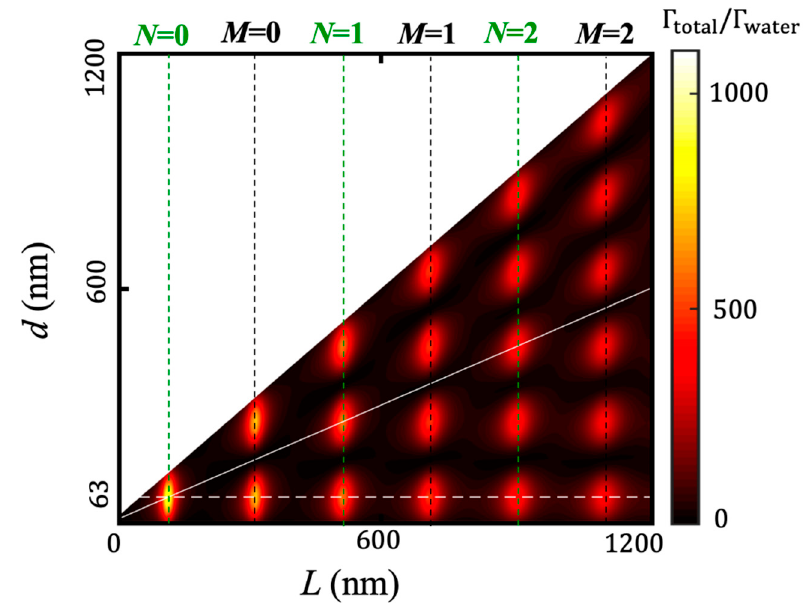
Figure 5. Normalized total spontaneous emission rate Γ total /Γ water depending on the point-source position d (distance from the point source to the left end of the aperture) and the aperture length L . The white solid and dashed lines are for d = L /2 (the point source being at the center of the aperture) and d = 63 nm , respectively, corresponding to Figure 2(a)–(b). The green and black vertical dashed lines show the aperture lengths determined by the phase-matching conditions of Eqs. (14) and (15), respectively. The results are obtained using the SPP model for an aperture width D = 30 nm and depth h =50 nm at λ = 1 μm .